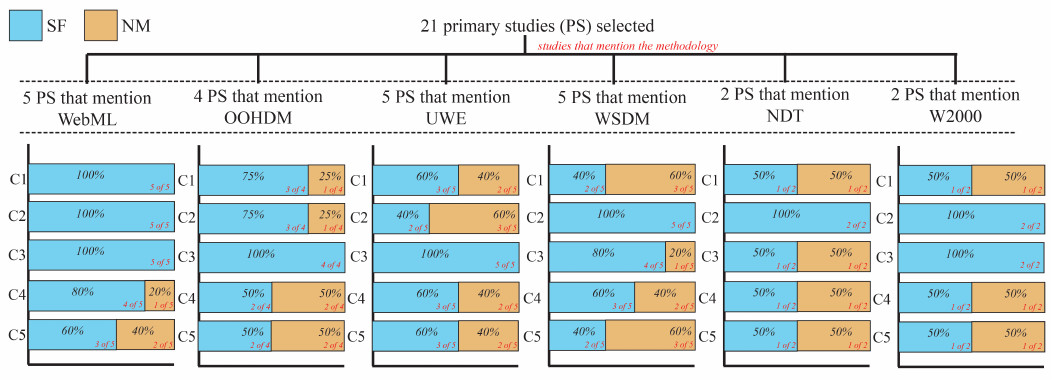
Figure 3. Quantitative analysis of primary studies by